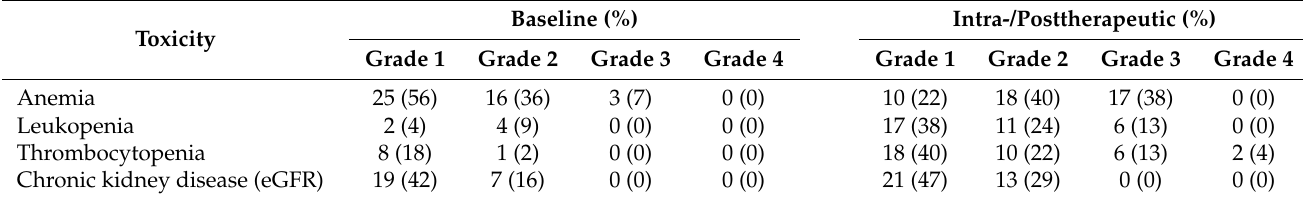
Table 3. Baseline and intra-/post-therapeutic hematologic toxicity grades based on CTCAE